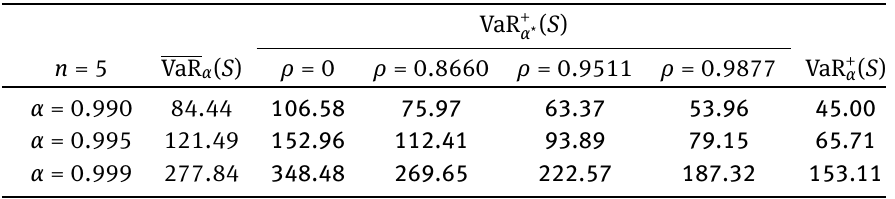
Table 2 The same as Table 1 with a Gaussian copula lower bound C X ≥ C Ga ρ on S = [ α , 1] n . The four values chosen for the correlation parameter ρ match the corresponding values of the pairwise Kendall’s rank correlation of the Gumbel copula in Table 1.